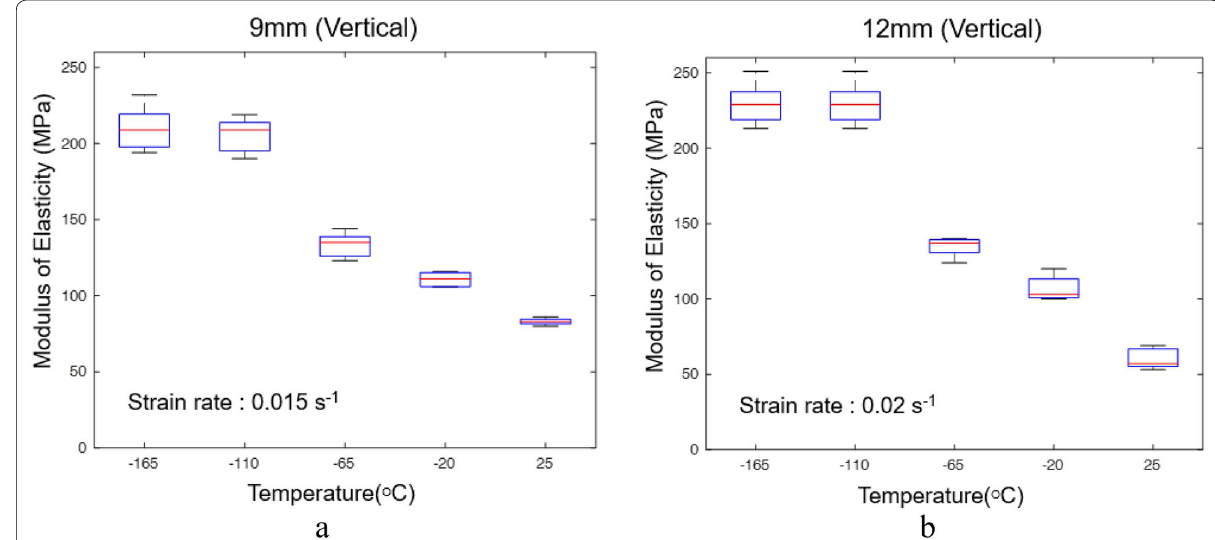
Fig. 14 a , b Average modulus of elasticity of plywood in the vertical fiber directions